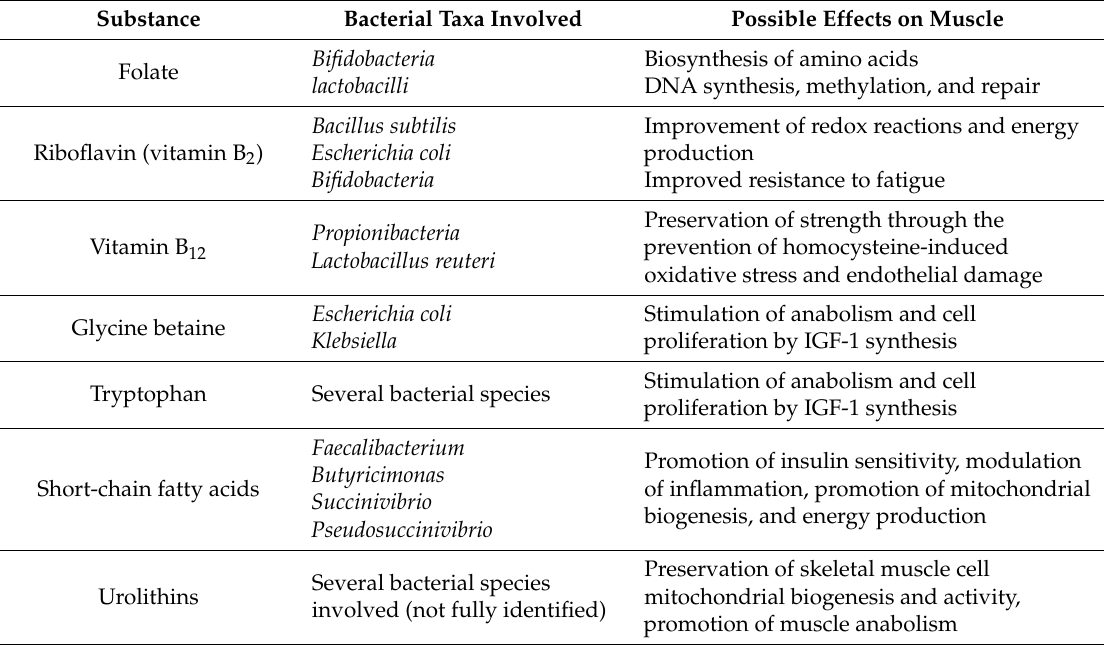
Table 3. Overview of the main microbial metabolites acting as nutrients or metabolic/physiological modulators for the host, which are also possibly involved in skeletal muscle